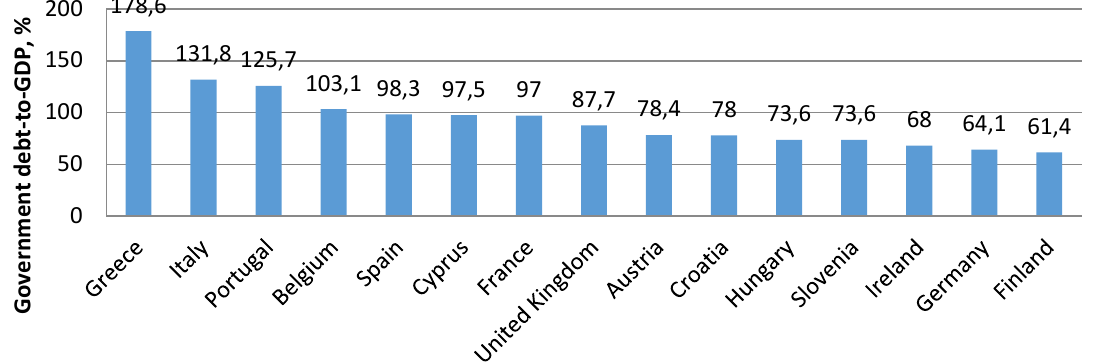
Source: Eurostat